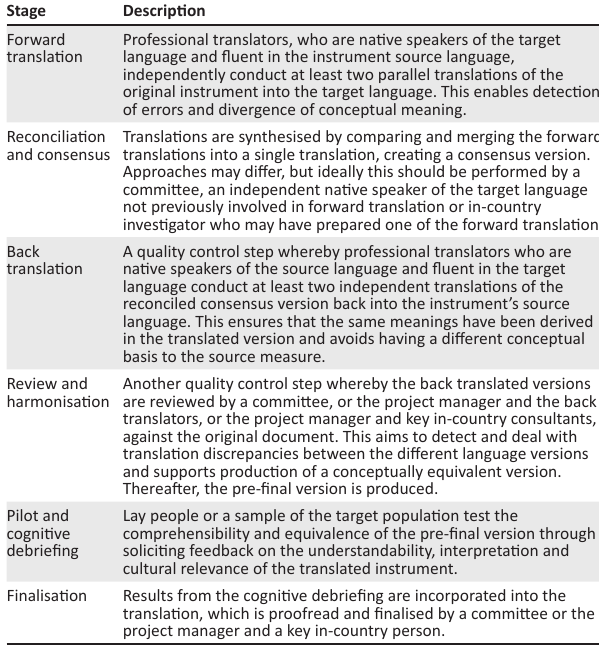
TABLE 1: Recommended criteria for translation methods used in the